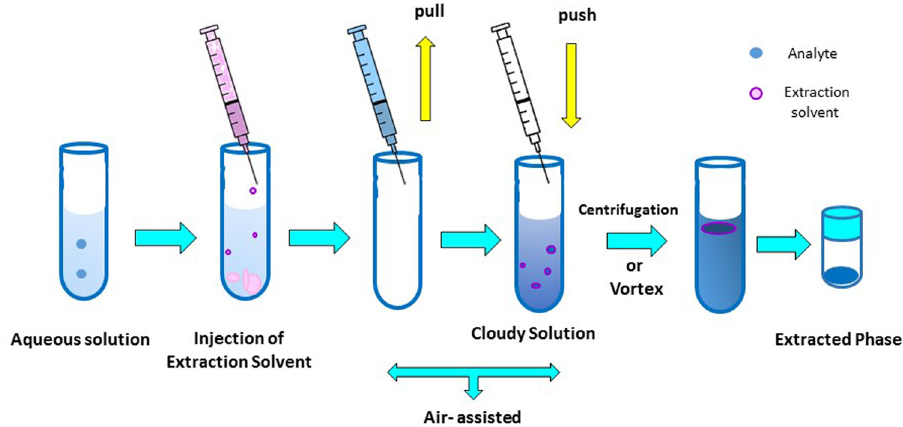
Figure 2: Basic AALLME schematic